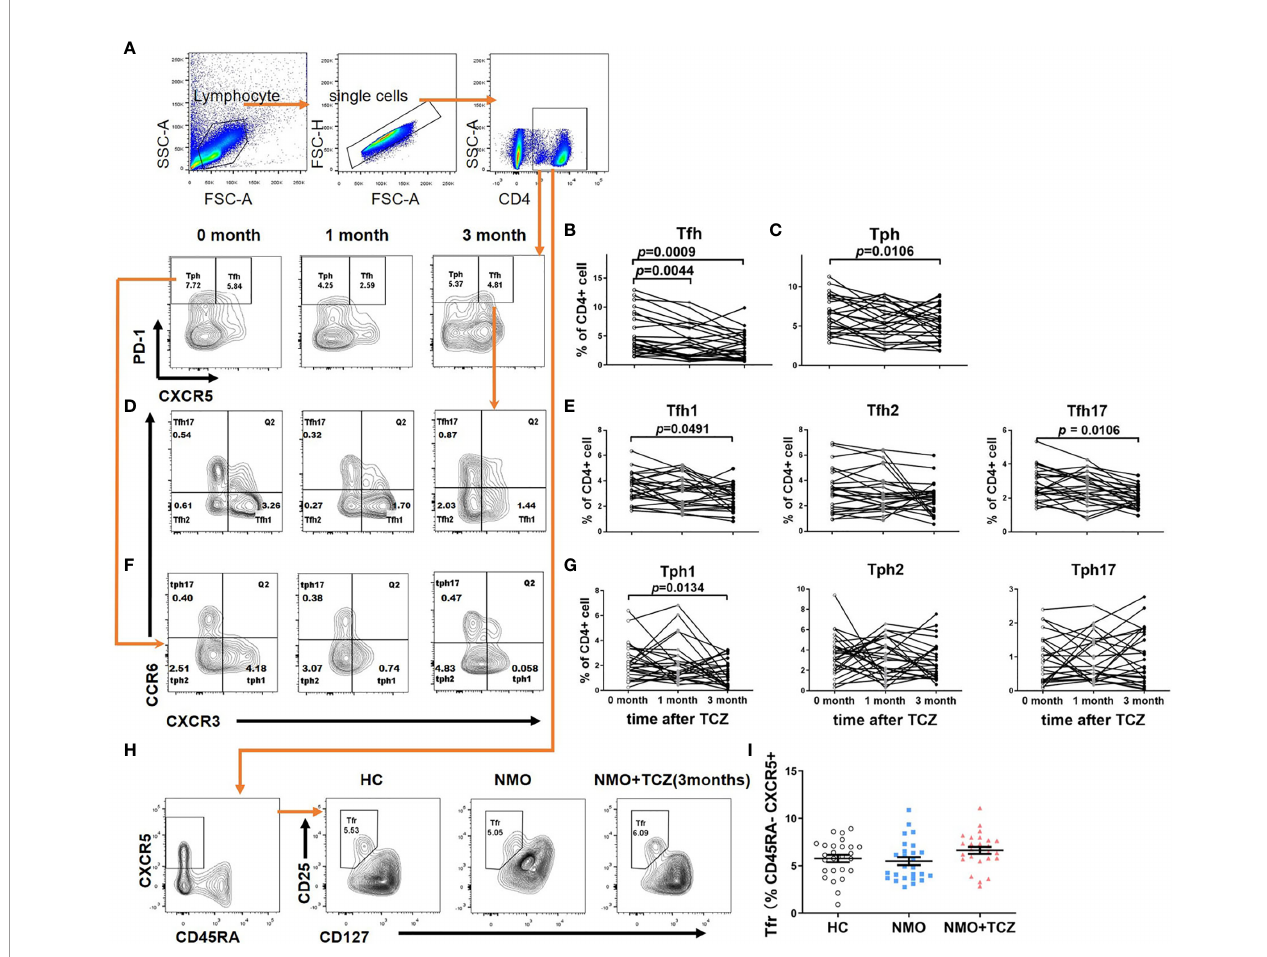
FIGURE 4 | T cells subsets distribution in NMOSD patients before and after tocilizumab. (A, D, F) showed gating strategy for subsets of T Follicular Helper Cell (Tfh) & peripheral T helper cells (Tph) and representative fl ow cytometry plot at baseline and after treatment for 1month or 3 months. (B, C, E, G) Quantitative analysis of proportion of total Tfh and its subsets: Tfh1 (CD4 + CXCR5 + PD-1 high CXCR3 + CCR6 – ), Tfh2 (CD4 + CXCR5 + PD-1 high CXCR3 – CCR6 – ) and Tfh17 (CD4 + CXCR5 + PD- 1 high CXCR3 – CCR6 + ), total Tph and its subsets: Tph1 (CD4 + CXCR5 - PD-1 high CXCR3 + CCR6 – ), Tph2 (CD4 + CXCR5 - PD-1 high CXCR3 – CCR6 – ), and Tph17 (CD4 + CXCR5 - PD-1 high CXCR3 – CCR6 + ) at baseline and after treatment for 1month or 3 months (n=19). (H) Gating strategy for T follicular Regulatory cells (Tfr) and fl ow cytometry plot of a control and a representative NMOSD patient (before and after tocilizumab 3 months). (I) Quantitative analysis of proportion of Tfr in healthy controls and NMOSD patient before and after tocilizumab 3 months (n=26). Differences were considered statistically signi fi cant for P <0.05. Paired, two-tailed Student ’ s t tests (if the distribution is normal) or Wilcoxon matched pairs tests (if it does not conform to the normal distribution) were used to compare baseline and post-treatment results,